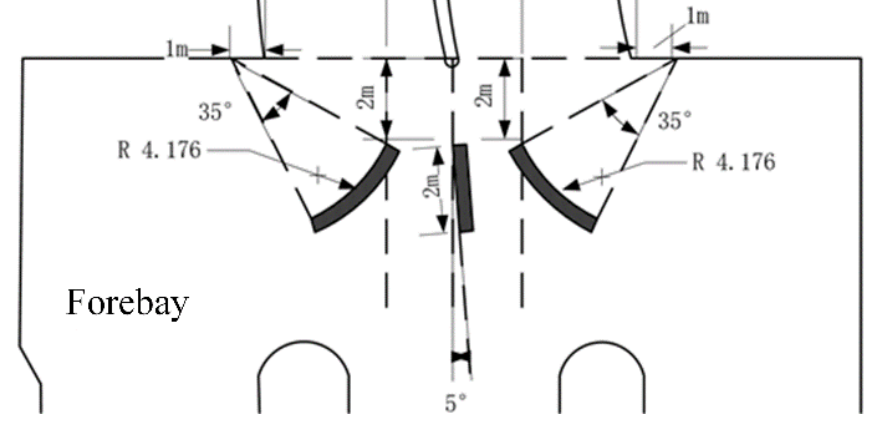
Figure 19. The construction drawing.